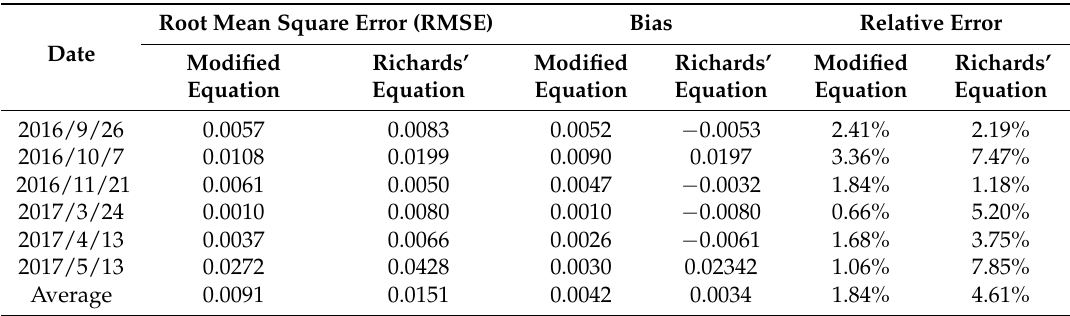
Table 3. Simulation accuracy of modified equation and Richards’ Equation for top soil layer (10 cm).